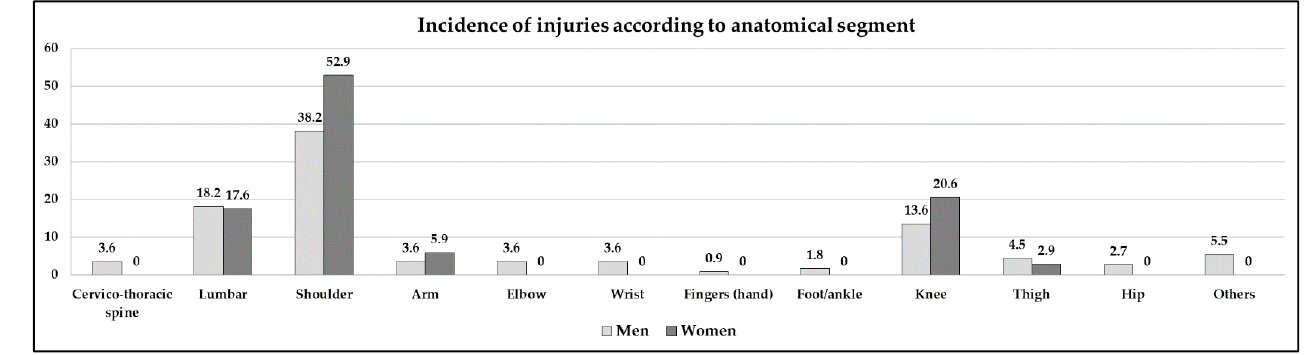
Figure 1. Incidence of injuries according to the anatomical